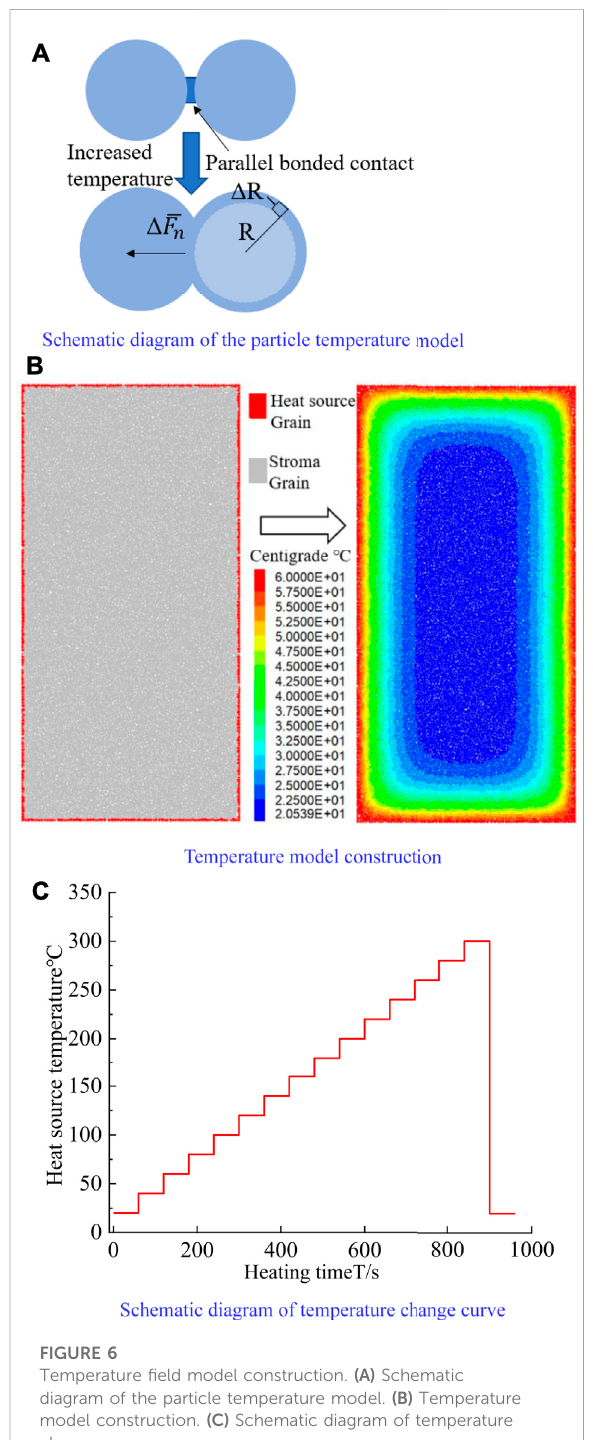
FIGURE 6 Temperature fi eld model construction. (A) Schematic diagram of the particle temperature model. (B) Temperature model construction. (C) Schematic diagram of temperature change